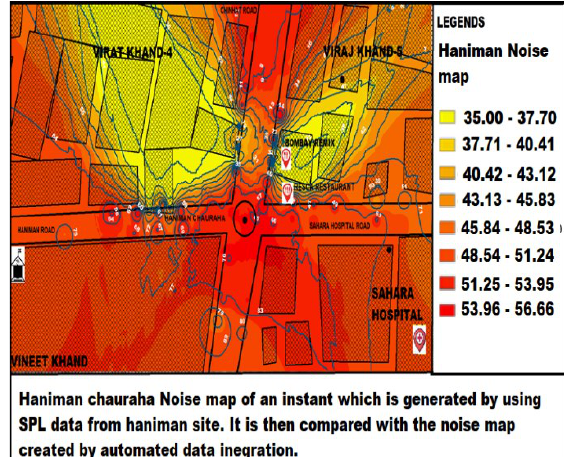
Figure 18. Noise strength of Haniman Chauraha Lucknow (INDIA) (R. Dubey et al.,